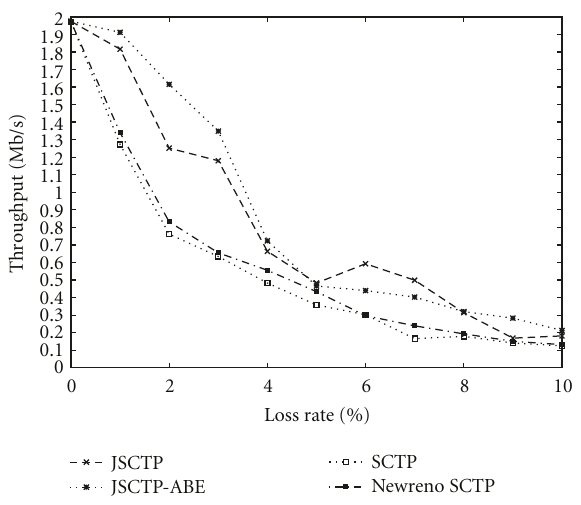
Figure 9: Throughput comparison with 1 ∼ 10% loss on both